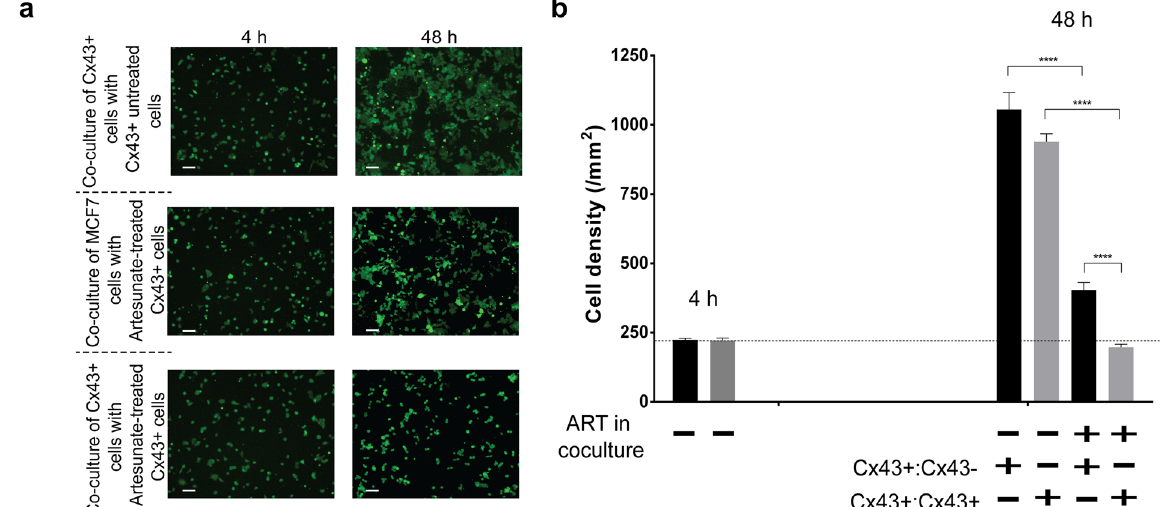
Figure 6. ART induced antiproliferative effect on bystander cells. MCF7 and Cx43-MCF7 cells labelled with CFSE were cocultured with unstained Cx43-MCF7 cells pre-treated with or without 20 µ M of ART for 6 h. Green fluorescent cells were counted 4 h after plating and 48 h after coculture. ( a ) Image represented the density of CFSE labelled MCF7 or Cx43-MCF 7 cells after 4 h and 48 h of coculture with ART treated or not unlabelled Cx43-MCF7 cells. Bar = 100 µ m. ( b ) Bystander cells in coculture were quantified in three independent experiments performed in